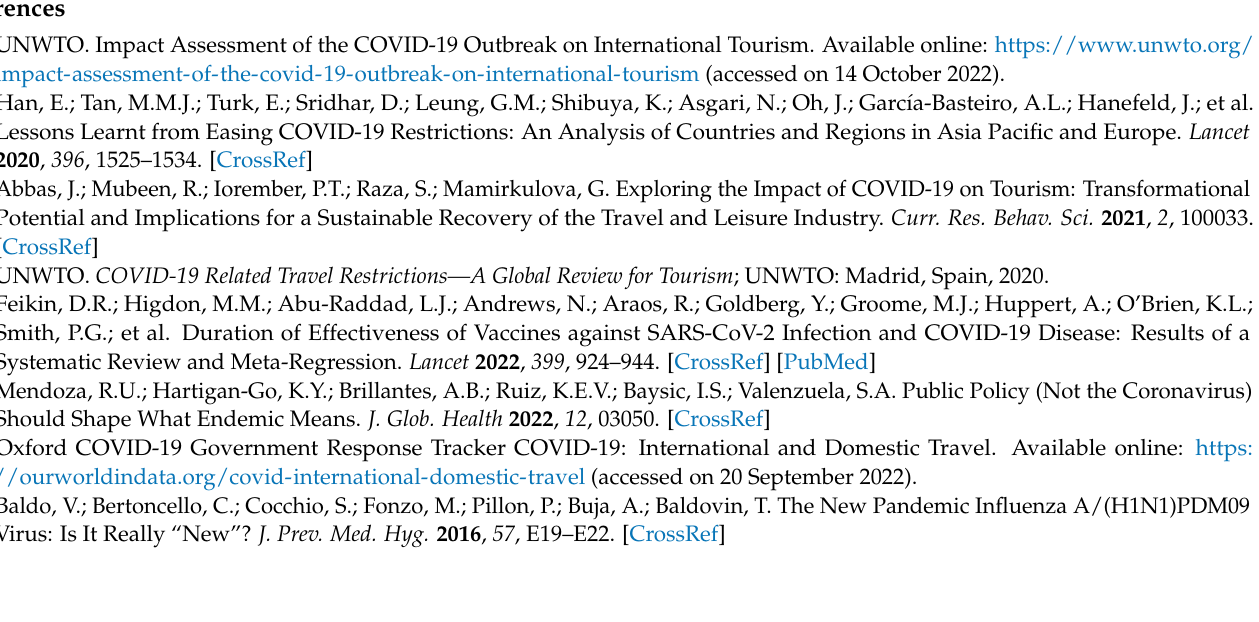
descriptions for Table S2.1; Table S1.1—Outcomes for Prealpha; Table S1.2—Outcomes for Alpha; Table S1.3—Outcomes for Delta (Unvac); Table S1.4—Outcomes for Delta (Vac); Table S1.5—Outcomes for Omicron (Vac); Table S1.6—Outcomes for Influenza A H1N1; Table S2.1—Min Quarantine